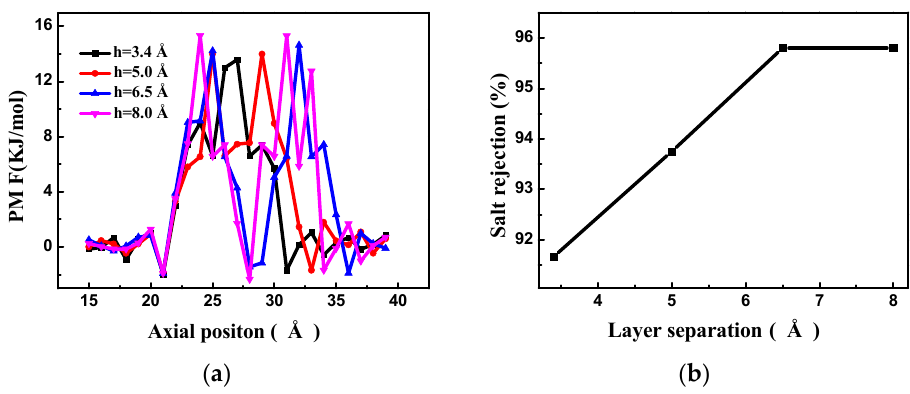
Figure 7. ( a ) The PMF of the bilayer porous graphene membrane for different layer separation distances; ( b ) salt rejection of the bilayer porous graphene membrane as a function of the layer separation.